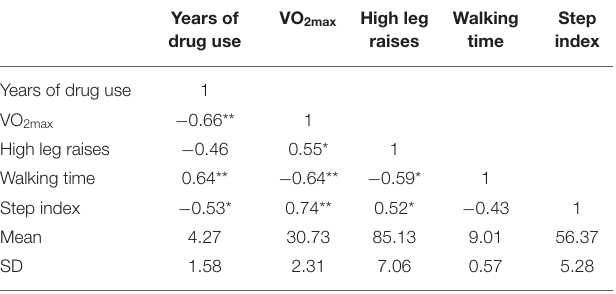
Years of VO 2max High leg Walking Step drug use raises time index